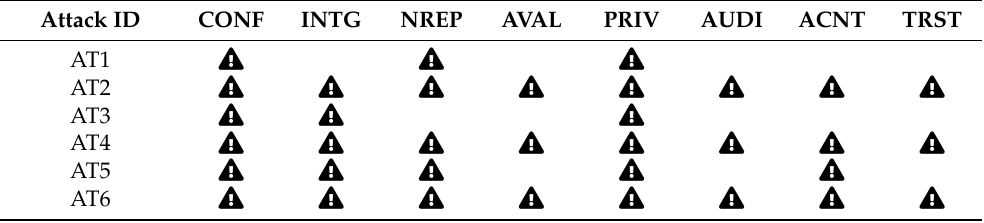
Table 2. Violated security goals per